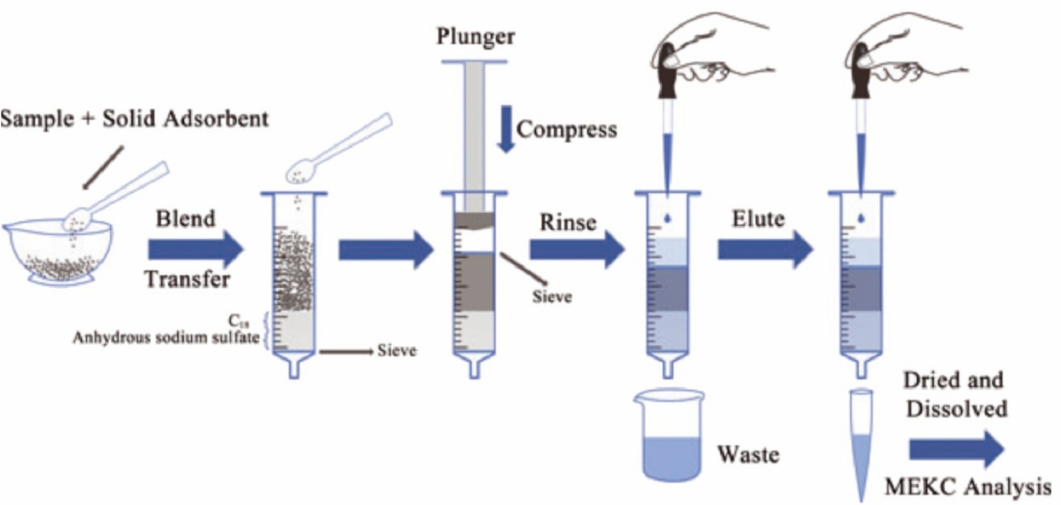
Figure 1. Four steps of SPE: conditioning, loading, washing, and elution. Reprinted by permission from [15]. Copyright 2018